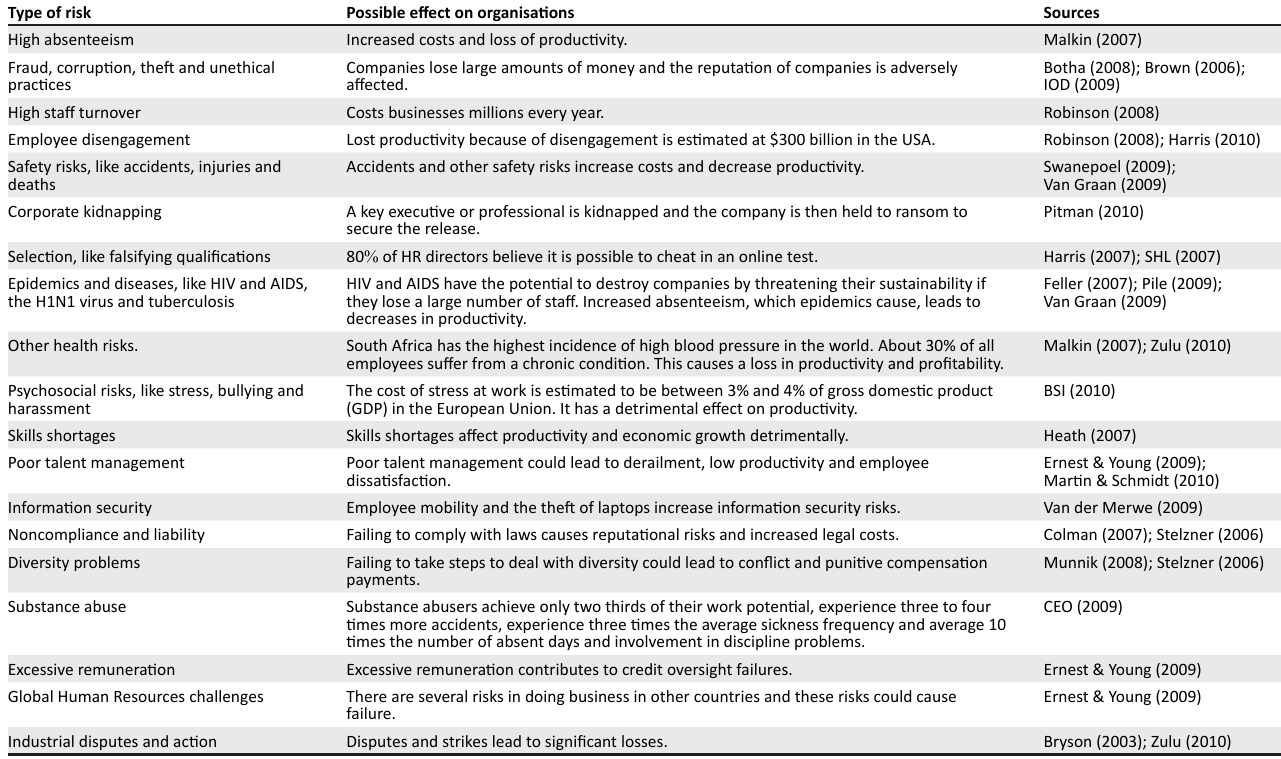
TABLE 3: Examples of Human Resources